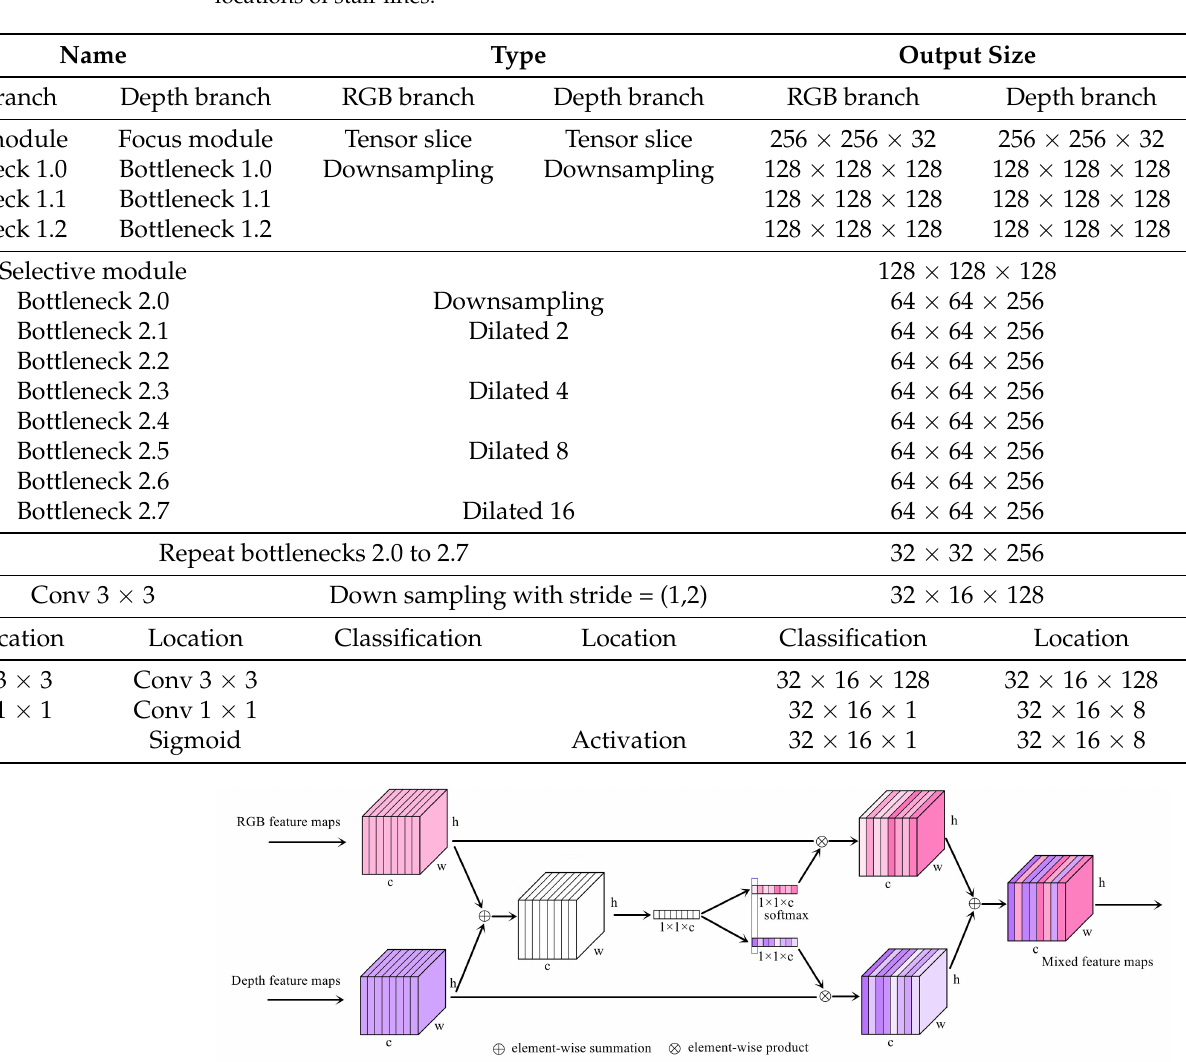
Figure 3. The selective module. The softmax function is applied to explore the complementary relationship between the RGB feature maps and the depth feature maps instead of simple summation and